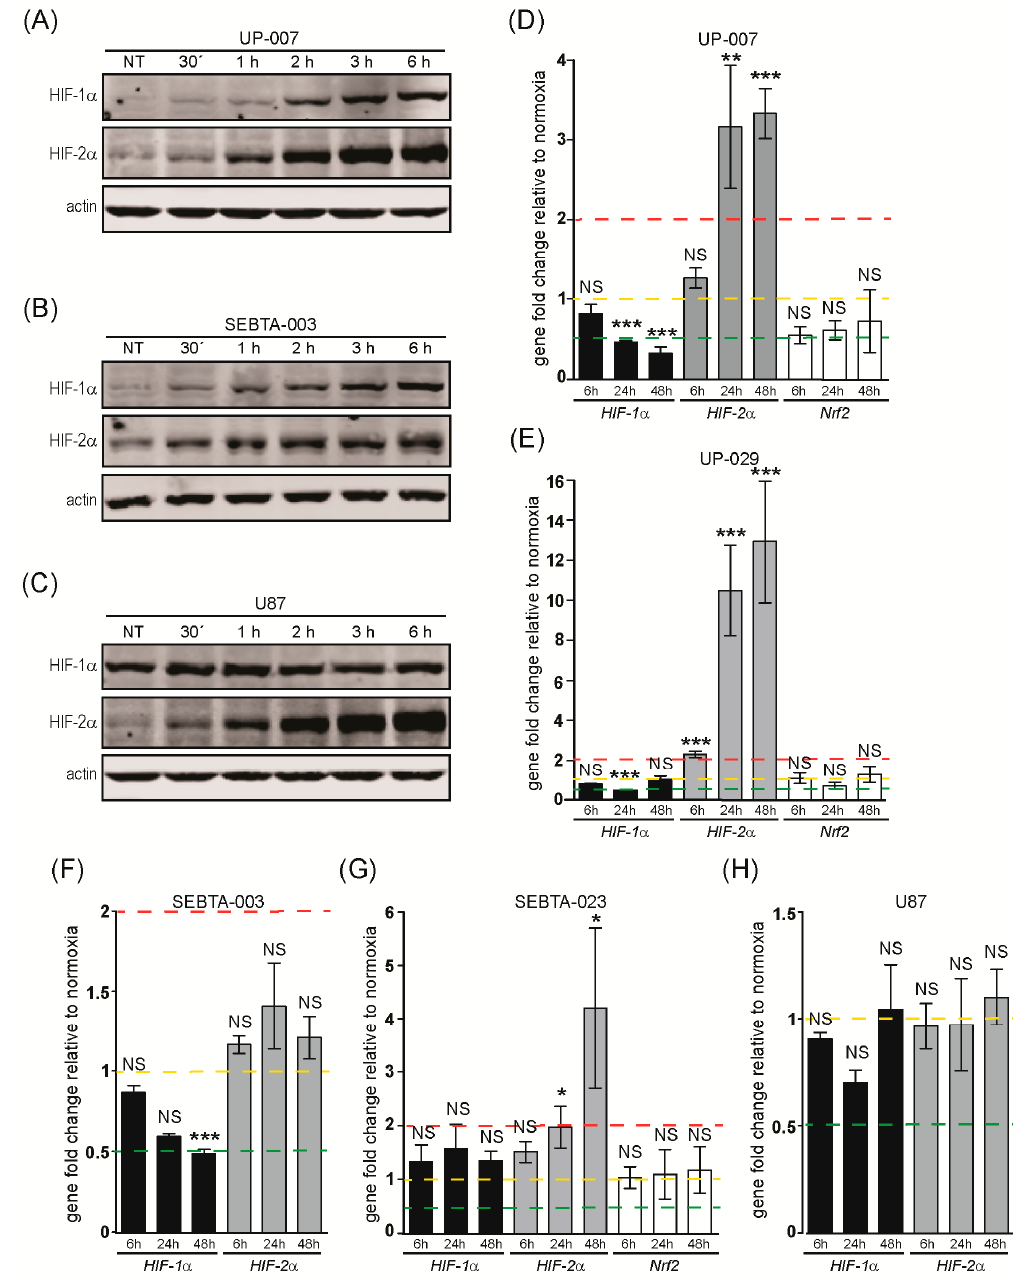
Figure 2. Analysis of transcription factor genes and proteins in hypoxic Glioblastoma (GB) cells. ( A ) UP ‐ 007; ( B ) SEBTA ‐ 003; or ( C ) U87 cells were incubated under normoxia (21% O 2 ) or hypoxia (1% O 2 ) for the times indicated. Cells were lysed and 20 μ g of each protein extract was subjected to SDS ‐ PAGE and analyzed by Western blotting with the antibodies indicated. ( D ) UP ‐ 007; ( E ) UP ‐ 029; ( F ) SEBTA ‐ 003; ( G ) SEBTA ‐ 023; or ( H ) U87 cells were incubated under normoxia (21% O 2 ) or hypoxia (1% O 2 ) for the times indicated. RNA extraction was performed and gene expression was determined by RT ‐ qPCR. Gene expression levels were normalized to RPLP0 mRNA using the 2 −ΔΔ CT method [13]. Error bars represent the Standard Deviations obtained from the median value of at least three independent experiments, each performed in triplicate. Statistical analysis was evaluated using two ‐ tailed Student’s t ‐ test, comparing each hypoxia time ‐ point to the respective normoxic control. In every case a p value of less than 0.05 (*), less than 0.01 (**), and 0.001 (***) was considered statistically significant.